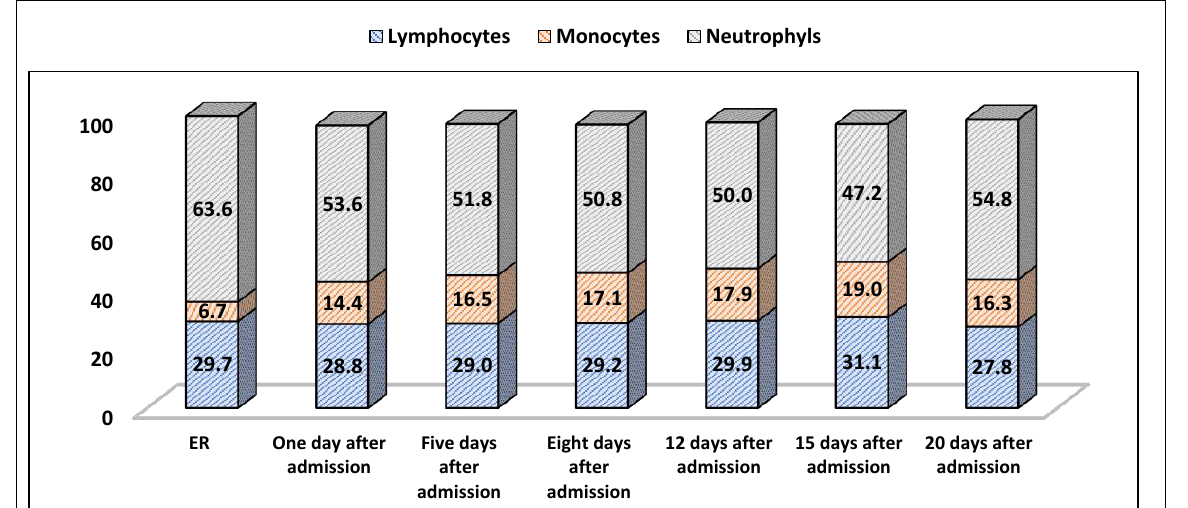
Figure 4. The patient ’ s white blood cell count in evolution.